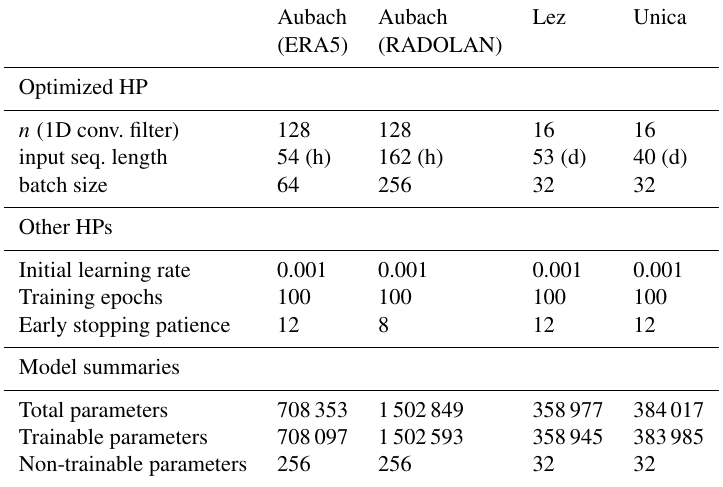
Table D1. Model parameter summary